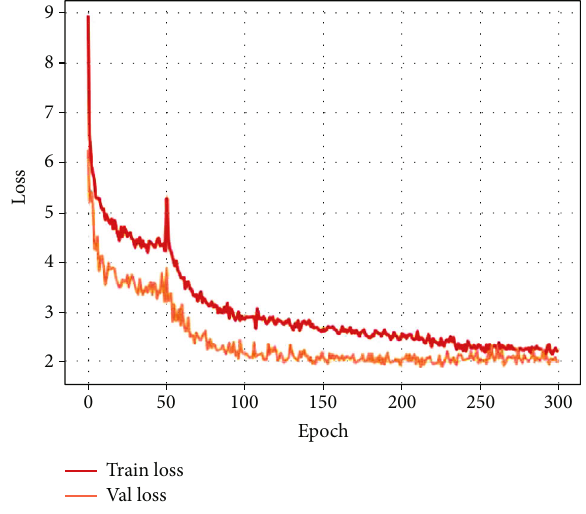
Figure 4: Loss curve of training